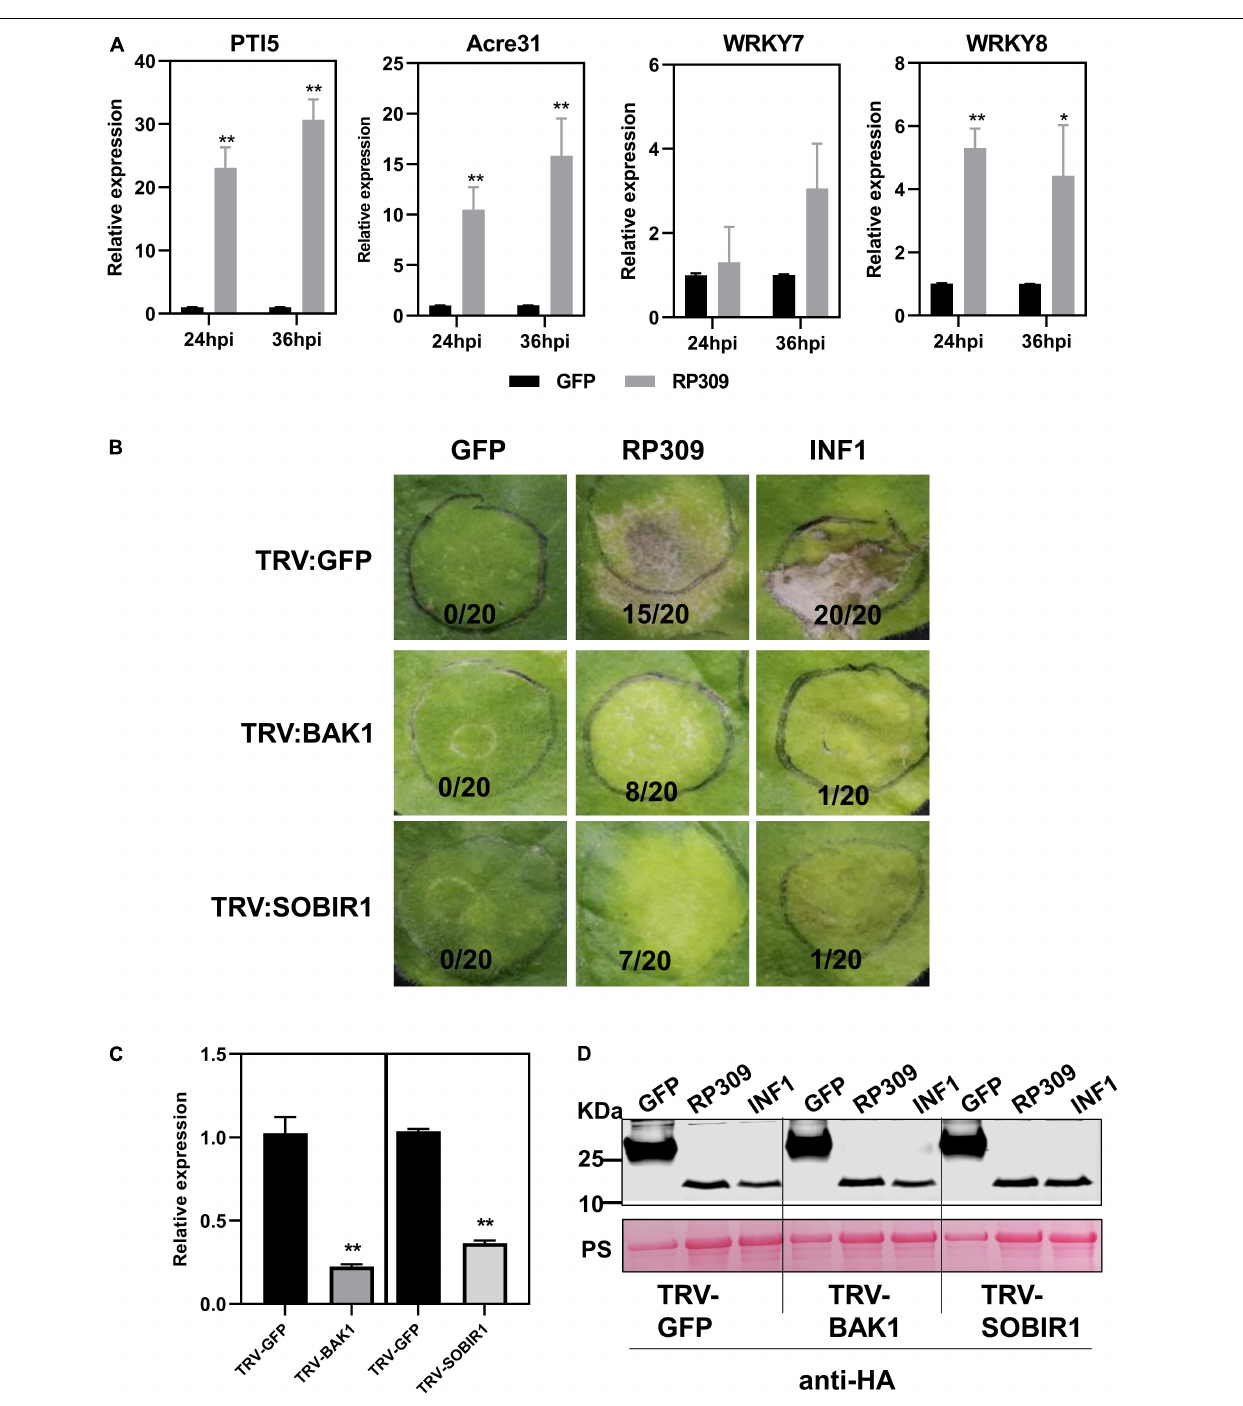
FIGURE 7 | RP309 activates the defense response in N. benthamiana . (A) Relative expression of the PTI marker genes in N. benthamiana leaves expression GFP-HA or RP309-HA. Similar results were obtained in three independent experiments. (B) TRV–based virus–induced gene silencing (VIGS) vectors were used to silence NbBAK1 and NbSOBIR1. TRV–GFP was used as a negative control. Photographs were taken 5 days post-infection. (C) The expression levels of NbBAK1 and NbSOBIR1 after VIGS–mediated silencing, as determined by quantitative real–time polymerase chain reaction (qRT–PCR). Asterisks at the top of the bars indicate statistical significance. Error bars represent ± SD (Student’s t -test, ** P < 0.01; * P < 0.05). (D) Immunoblot analysis of GFP, RP309, and INF1 expressed in N. benthamiana leaves. Asterisk represents the destination strip.